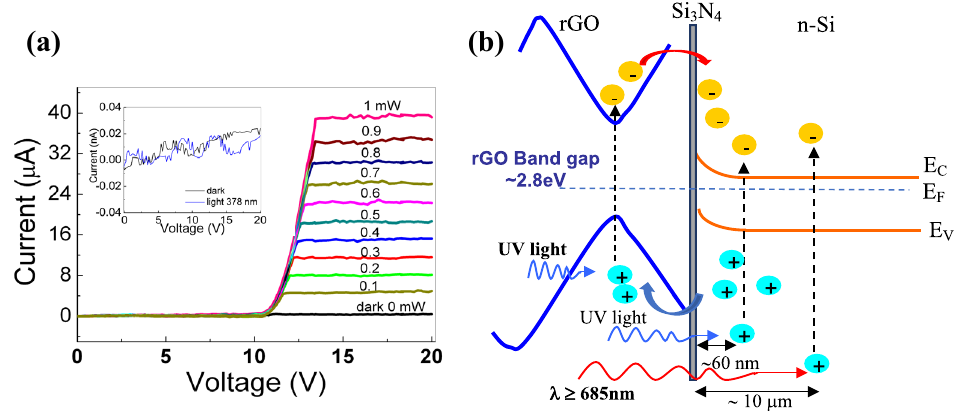
Figure 6. ( a ) I–V characteristics of the rGO/n-Si photodetector device. The photoconductive current has been measured in reverse bias configuration. (inset) the I–V characteristics of the n-Si based substrate with and without laser light at 378 nm; ( b ) a proposed energy band diagram of the rGO/n-Si heterojunction under light illumination at reverse bias. The rGO bandgap is about 2.8 eV. The UV (blue arrow) and infrared (red arrow) radiation are reported. The penetration depth in the n-Si is of the order of 60 nm for a wavelength of about 378 nm and 10 µm for a wavelength of 685